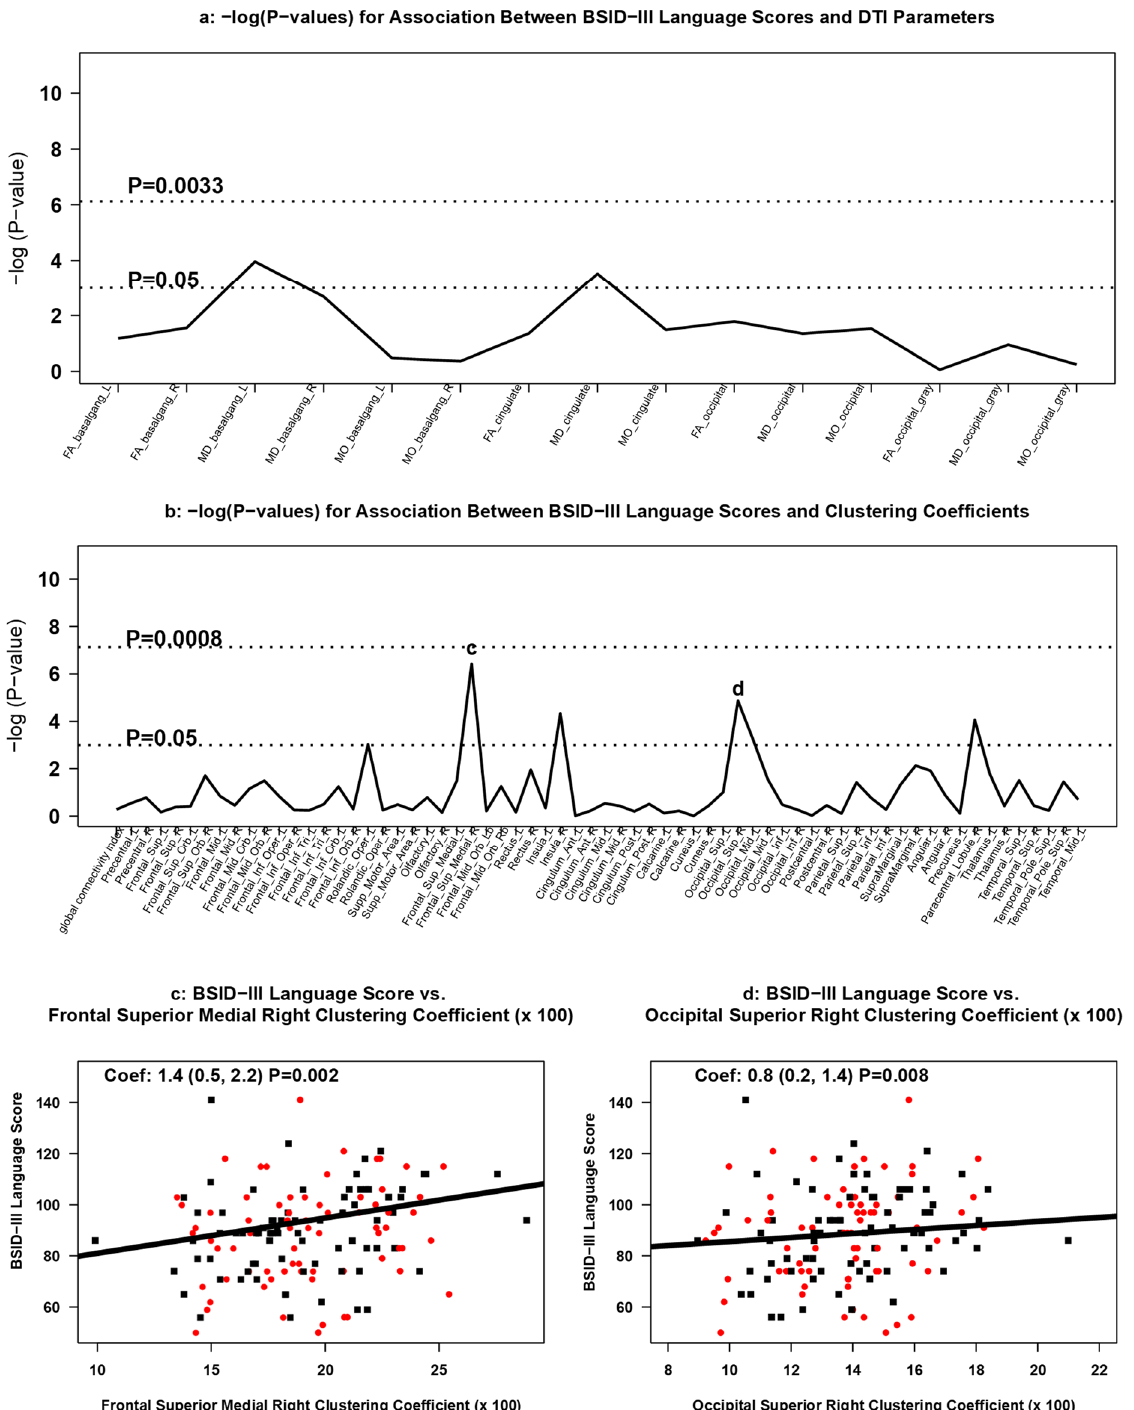
Figure 8. Association between DTI measures and BSID-III language scores. Manhattan plots of [GEE-based Wald test] -log ( p -values) for differences in ( a ) regional DTI diffusion values and ( b ) clustering coefficients by BSID-III language scores. Panels ( c , d ) display scatterplots of BSID-III language scores and statistically significant [GEE-based] associations in clustering coefficients. Red dots represent infants treated with Epo; black squares represent infants treated with placebo.